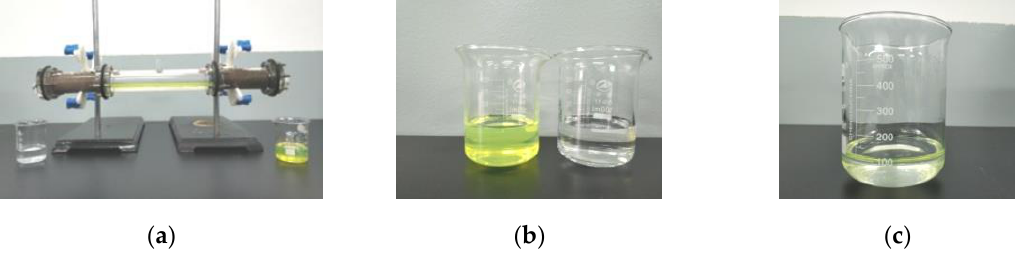
Figure 8. Experimental diagram of filtering oil/water mixture. ( a ) Continuous oil/water separation device filters the mixture of diesel and water; ( b ) oil and water after filtration; ( c ) penetration on the water outlet side and filter out the oil.